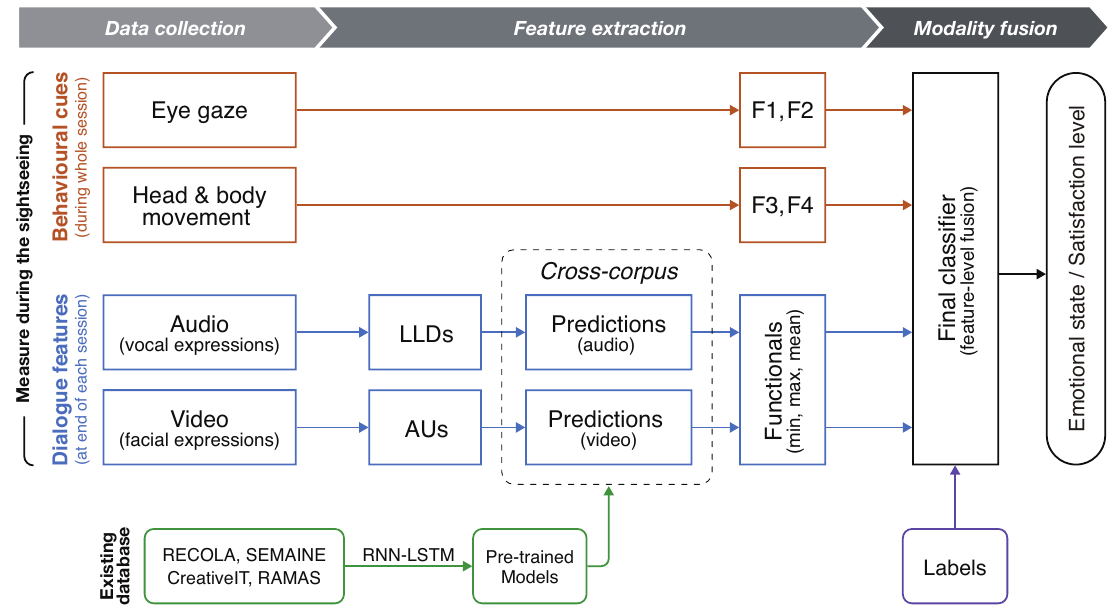
Figure 5. Scheme of tourist emotion and satisfaction estimation with modality fusion. LLDs: low-level descriptors of prosodic, spectral, cepstral, and voice quality, AUs: action units for describing facial expressions, F1: intensity of eye movement, F2: statistical features of eye movement, F3: